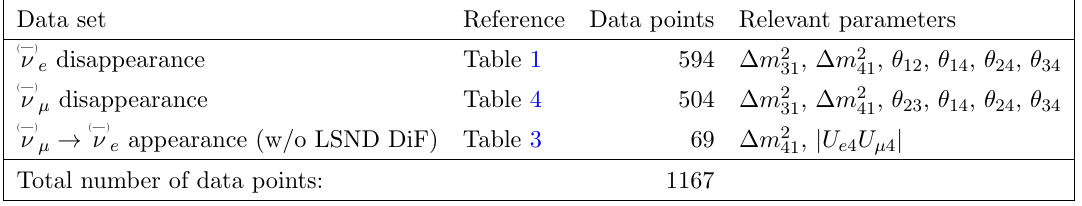
Table 5 . Number of degrees of freedom and parameters relevant to the counting of degrees of freedom for each data set. More details on the individual experiments are given in the corresponding tables. The number of degrees of freedom for the LSND decay-in-(cid:13)ight analysis is not available. Thus, in the sum of degrees of freedoms for appearance and all data sets, we used the LSND decay-at-rest number. See text for details and comments on additional nuisance